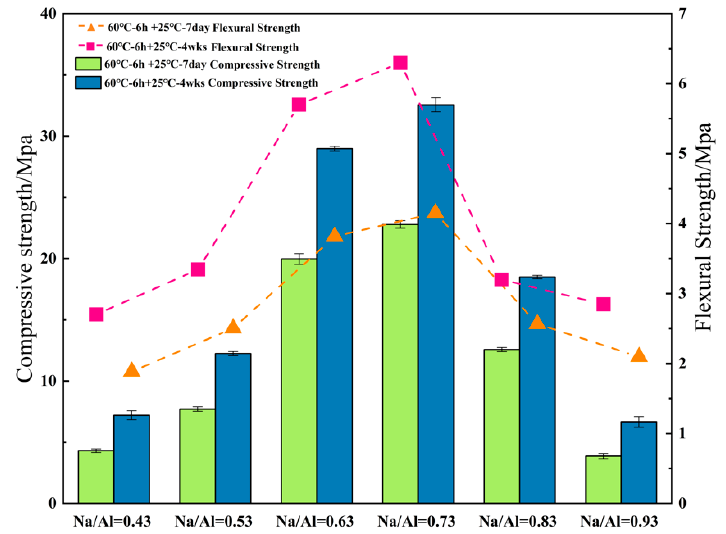
Figure 8. Compressive strength and flexural strength of geopolymer samples with various Na/Al ratios.